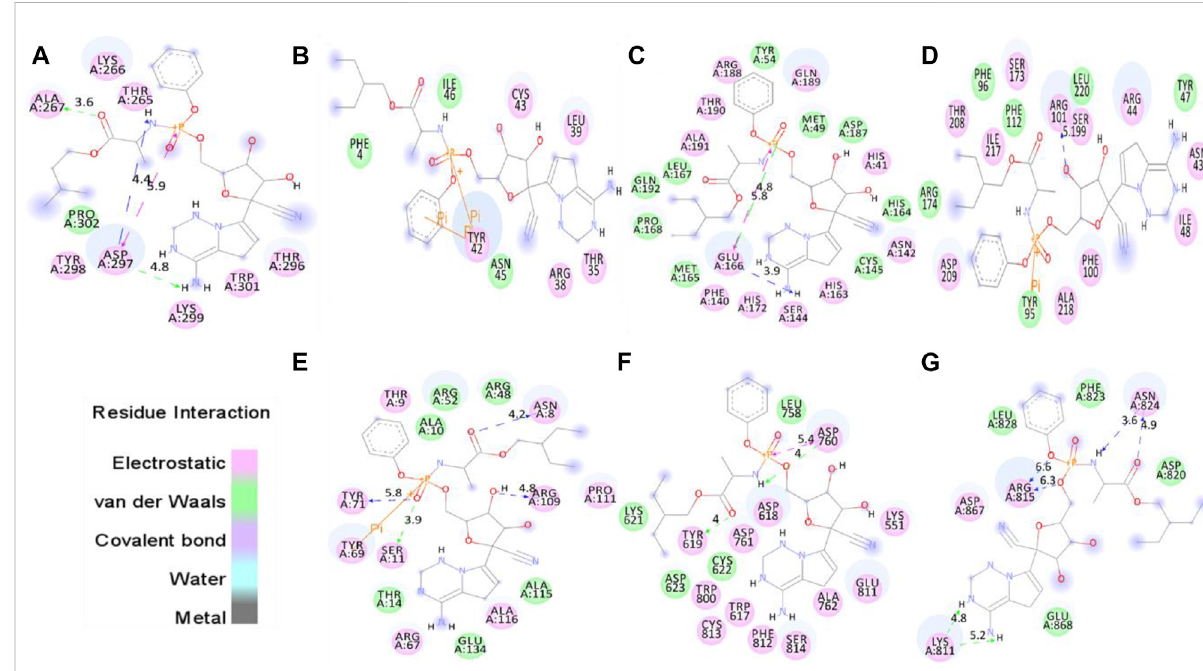
The molecular docking of remdesivir into the active pocket of CTD, Eprotein, Mprotease, Mprotein, NTD, RDP, and Sprotein, respectively. The structureindicateddifferentresidualinteractionsin (A) CTD-remdesivir, (B) Eprotein-remdesivir, (C) Mprotease-remdesivir, (D) Mprotein-remdesivir,